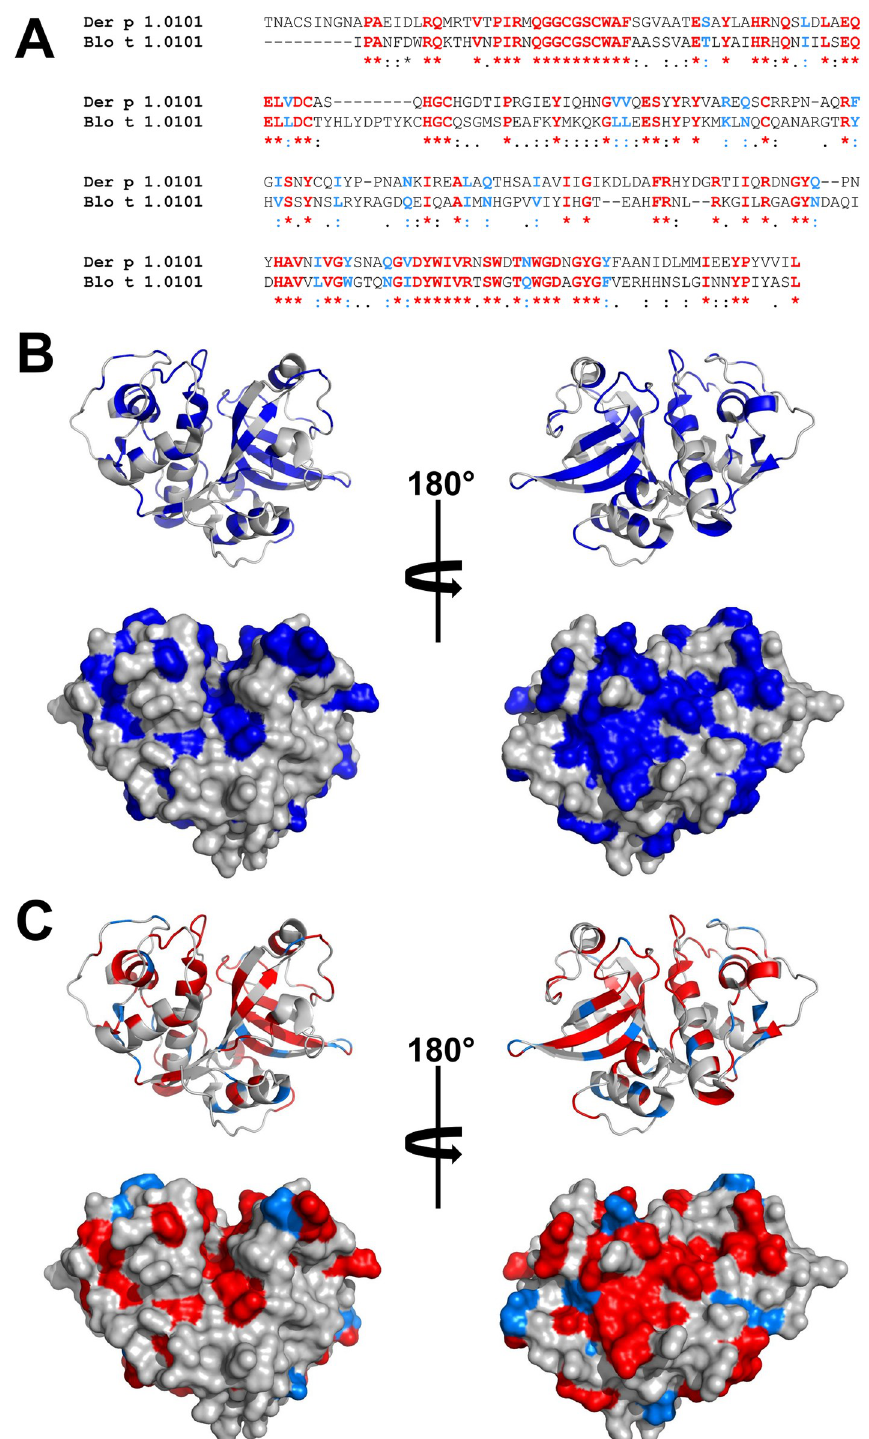
Fig 1. Comparison of Der p 1.0101 and Blot 1.0101. (A) Sequence alignment of Der p 1.0101 and Blo t 1.0101 made with Clustal Omega. Similar residues are marked with bold font type. Similarity definition corresponds to a default setting of the SIAS server. Identical residues are marked in red, while residues marked in light blue correspond to the difference between similar and identical residues. Consensus line corresponds to the similarity definition used by Clustal Omega. It is important to note that the similarity definition used by SIAS is more conservative than the one used by Clustal Omega. (B) Similar amino acids (blue) marked on the structure of Der p 1. The structure is shown